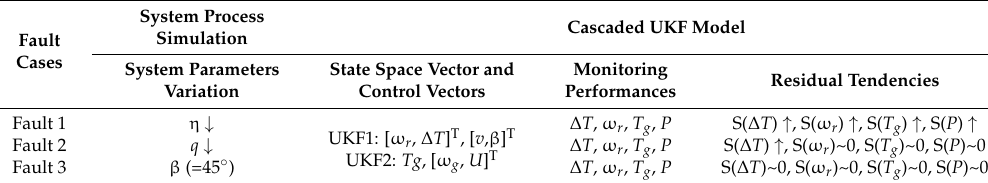
Table 2. System simulation and UKF model input and output parameters